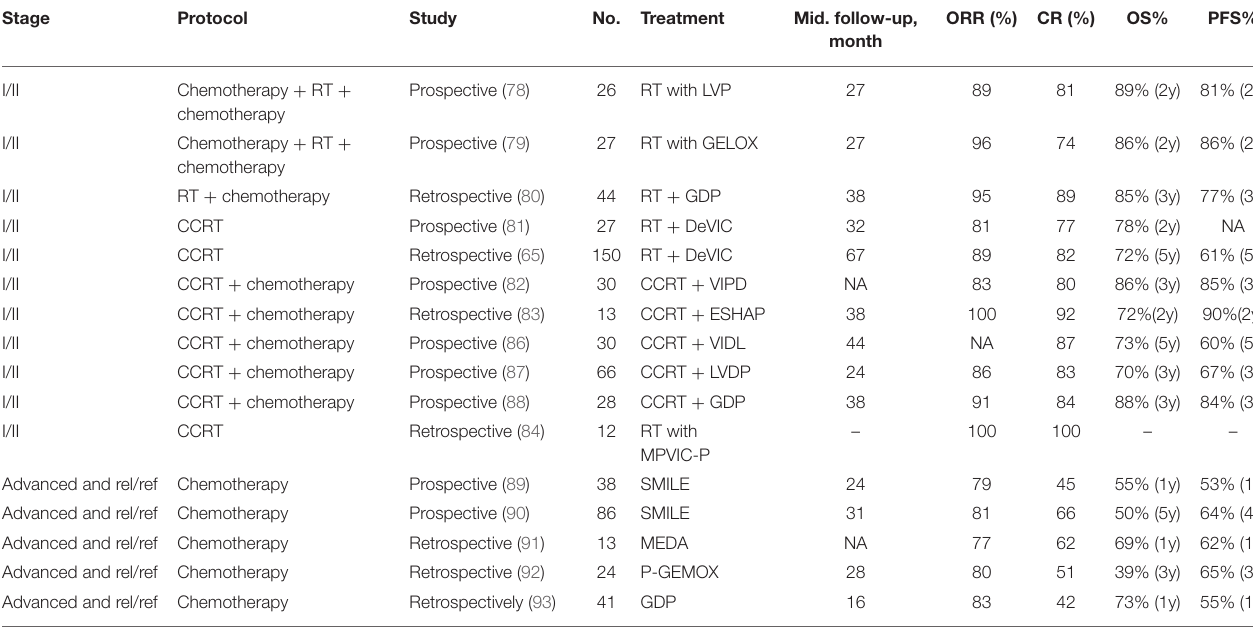
TABLE 2 | Selected clinical studies on the radiotherapy and chemotherapy of ENKL. Stage